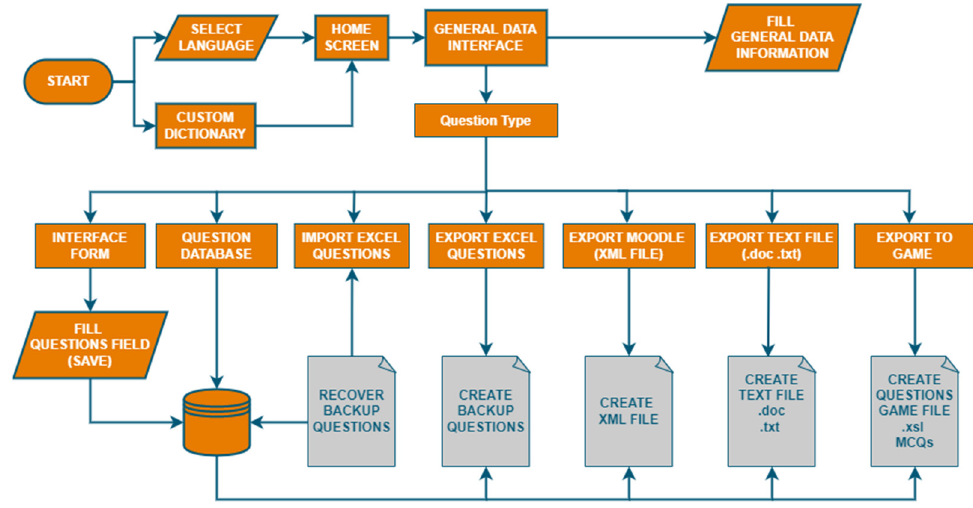
Figure 1. Architecture of FastTest